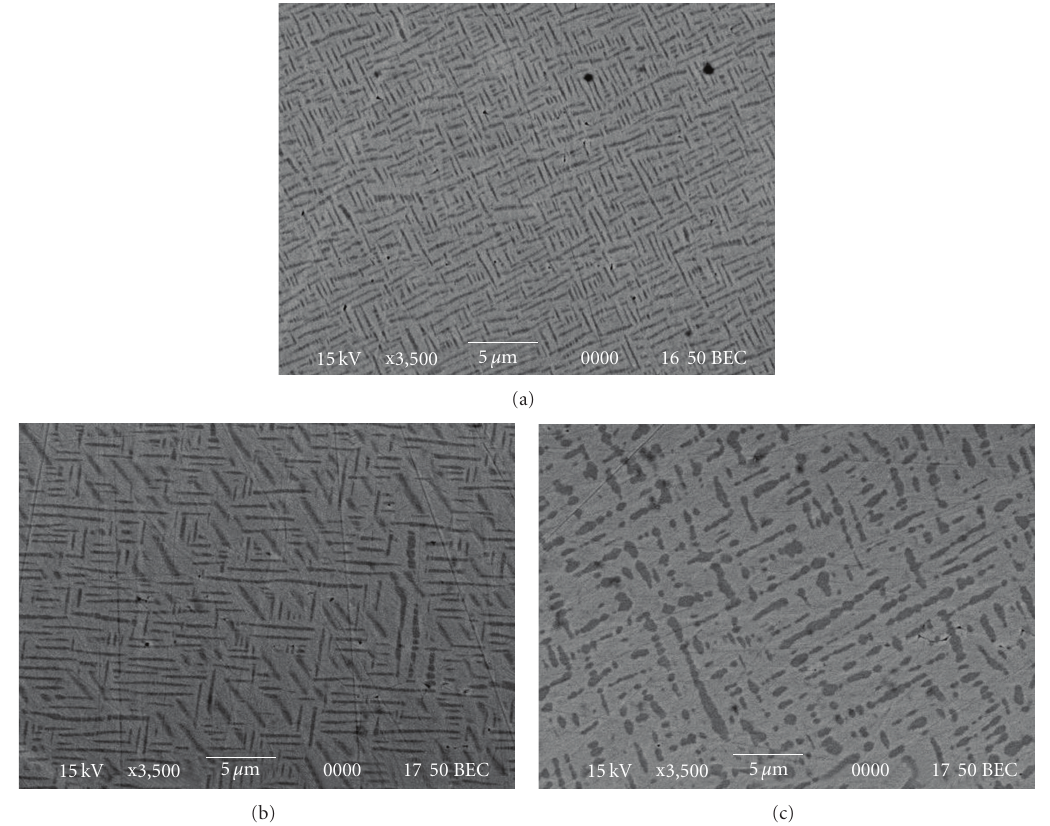
Figure 5: SEM micrographs of Ni-15at%Al(arc) after annealing at 900 ◦ C for 24h (a), 72 h (b), and 120 h (c).